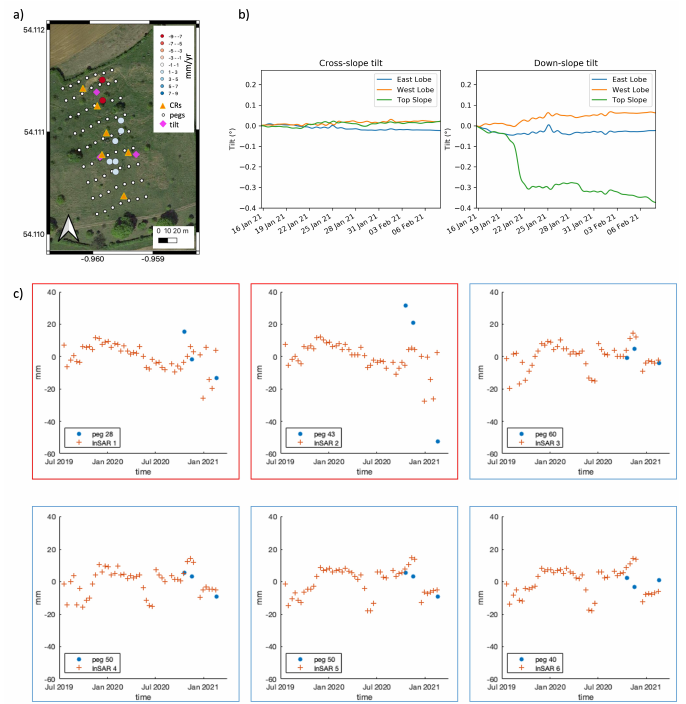
Figure 9. ( a ) InSAR velocities derived from ascending acquisitions since the installation of the 6 corner reflectors in July 2019. Coloured circles show the location and velocities of coherent pixels. These correspond to signals from the corner reflectors. Orange triangles show the location of corner reflectors, white dots show the location of new pegs placed on the ground in 2020 and magenta diamonds show the locations of the three tiltmeters installed in January 2021. ( b ) Time series of the tiltmeters installed in mid-January 2021. Left and right panels show cross-slope and down-slope tilt in degrees, respectively. ( c ) Individual InSAR time series (orange +) compared to movements of the closest peg in the ascending InSAR line-of-sight direction (blue circles). Time series corresponding to the 2 northern (velocities marked with red) points are shown in the red boxes, while examples of the pixels from the lower parts of the slope are shown in the blue boxes. InSAR points are marked from north to south, and the plotted pegs are of the location closest to the corresponding InSAR